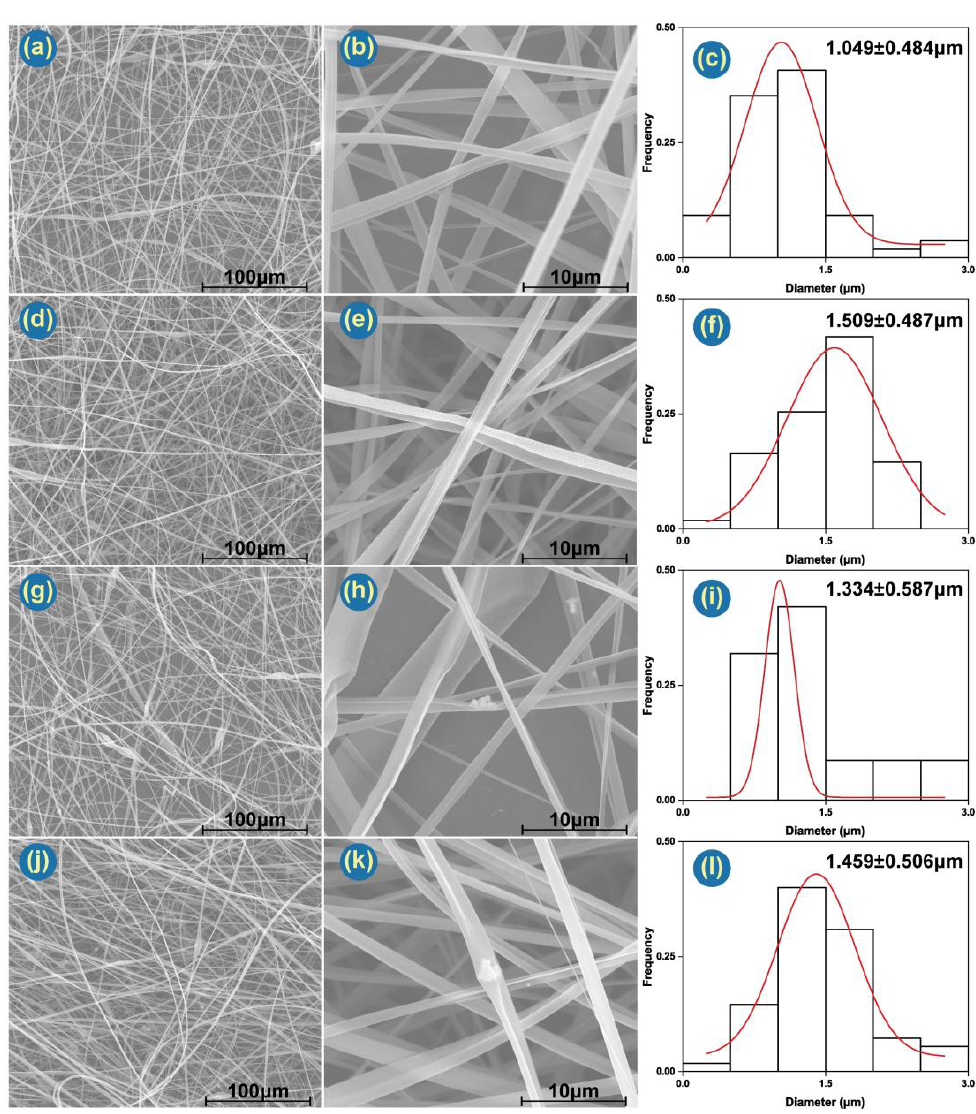
Figure 3. SEM images of the fibers: ( a , b ) F1; ( d , e ) F2; ( g , h ) F3; ( j , k ) F4. ( c , f , i , l ) are the distributions of fiber diameter determined from ( b , e , h , k ), respectively.